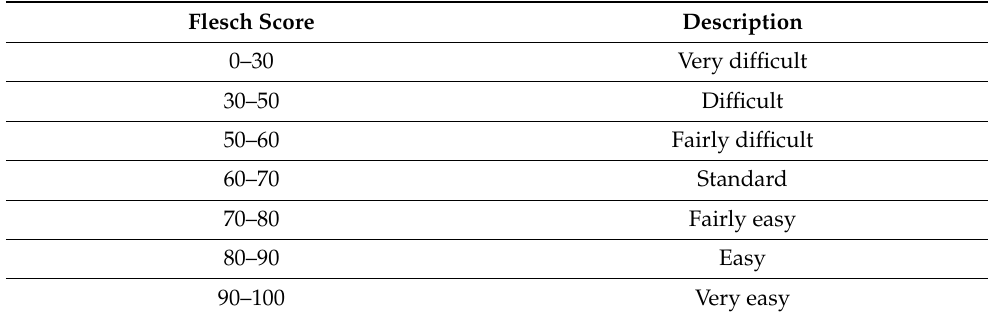
Table 2. Flesch reading ease score and